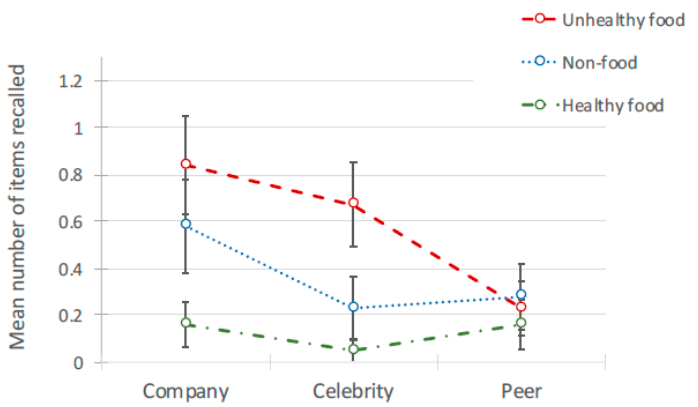
Figure 7. Interaction between brand recall and source of ad for 3 types of ad. Table 5. Recall and recognition: Means, standard deviations, and 95% confidence intervals for recalled and recognised brands.